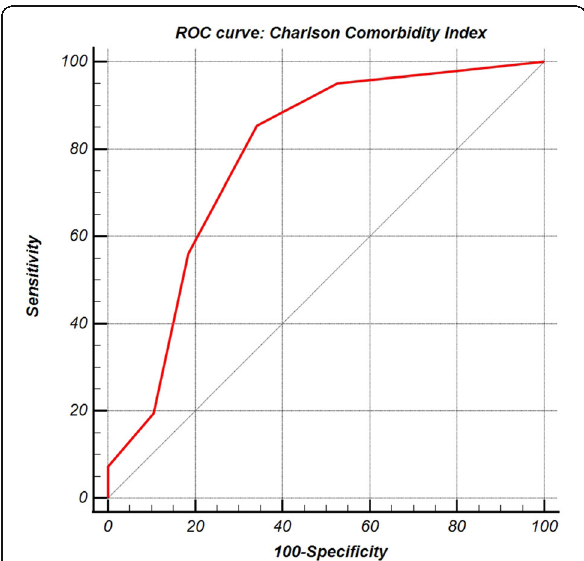
Fig. 2 ROC curve analysis for the Charlson Comorbidity Index. The figure shows ROC curve analysis for the Charlson Comorbidity Index (AUC 0.784, CI 95% 0.677 – 0.869, p -value < 0.0001). The coefficient for the score and cut-off values were: score model [Charlson] = 0.2762